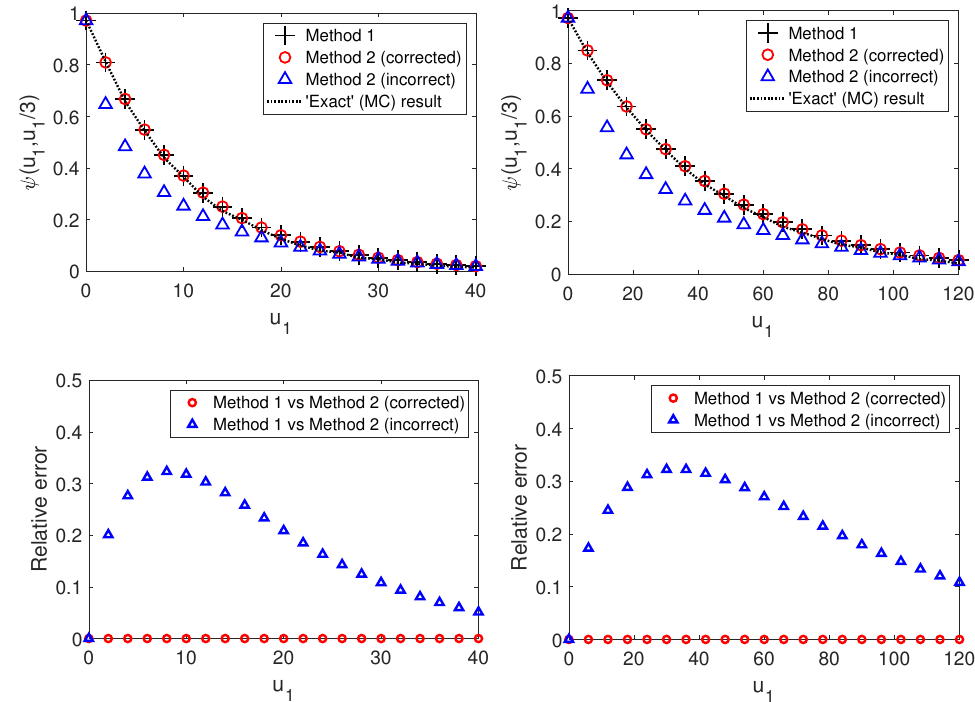
Figure 1. A comparison of the ruin probability values obtained using Theorem 1 (Method 1) and Formula (26) (Method 2) in correct and incorrect versions and using Monte Carlo simulations (’Exact’ result, 10,000 repetitions), upper panels; relative errors compared with Method 1, bottom panels. The left panels correspond to exponential claims with β = 2 and the right panels to β = 0.5. Common